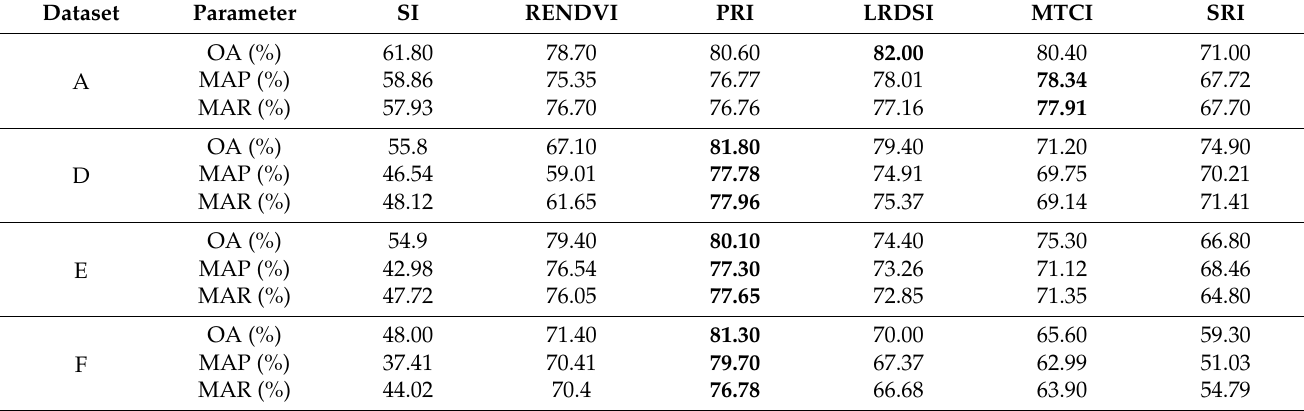
Table 4. OA, MAP and MAR values for different datasets based on single-index random forest classification. OA, MAP and MAR are overall accuracy, macro average of precision and macro average of recall, respectively. Maximum value of each parameter is highlighted in bold, and dataset details are described in Table